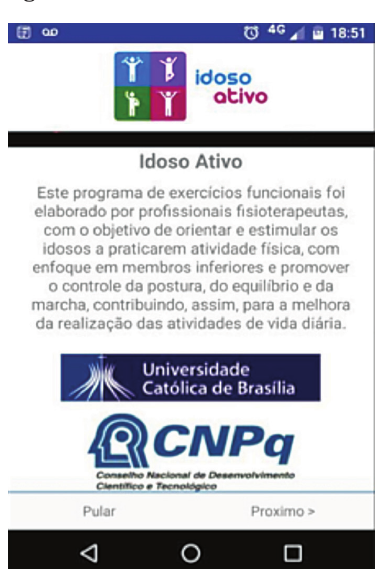
Figure 1 - Initial screen with the application